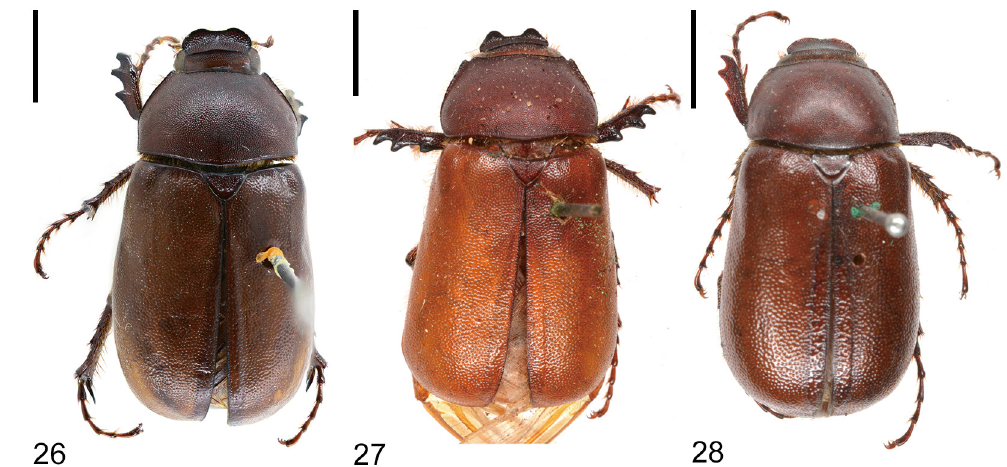
Figs 26–28. Habitus in dorsal view. 26 . Miridiba abdominalis (Hope, 1831), lectotype (BMNH). 27 . M. bilobata (Moser, 1913), lectotype (BMNH). 28 . M. castanea (Waterhouse, 1875), lectotype (BMNH). Scale bars = 5.0